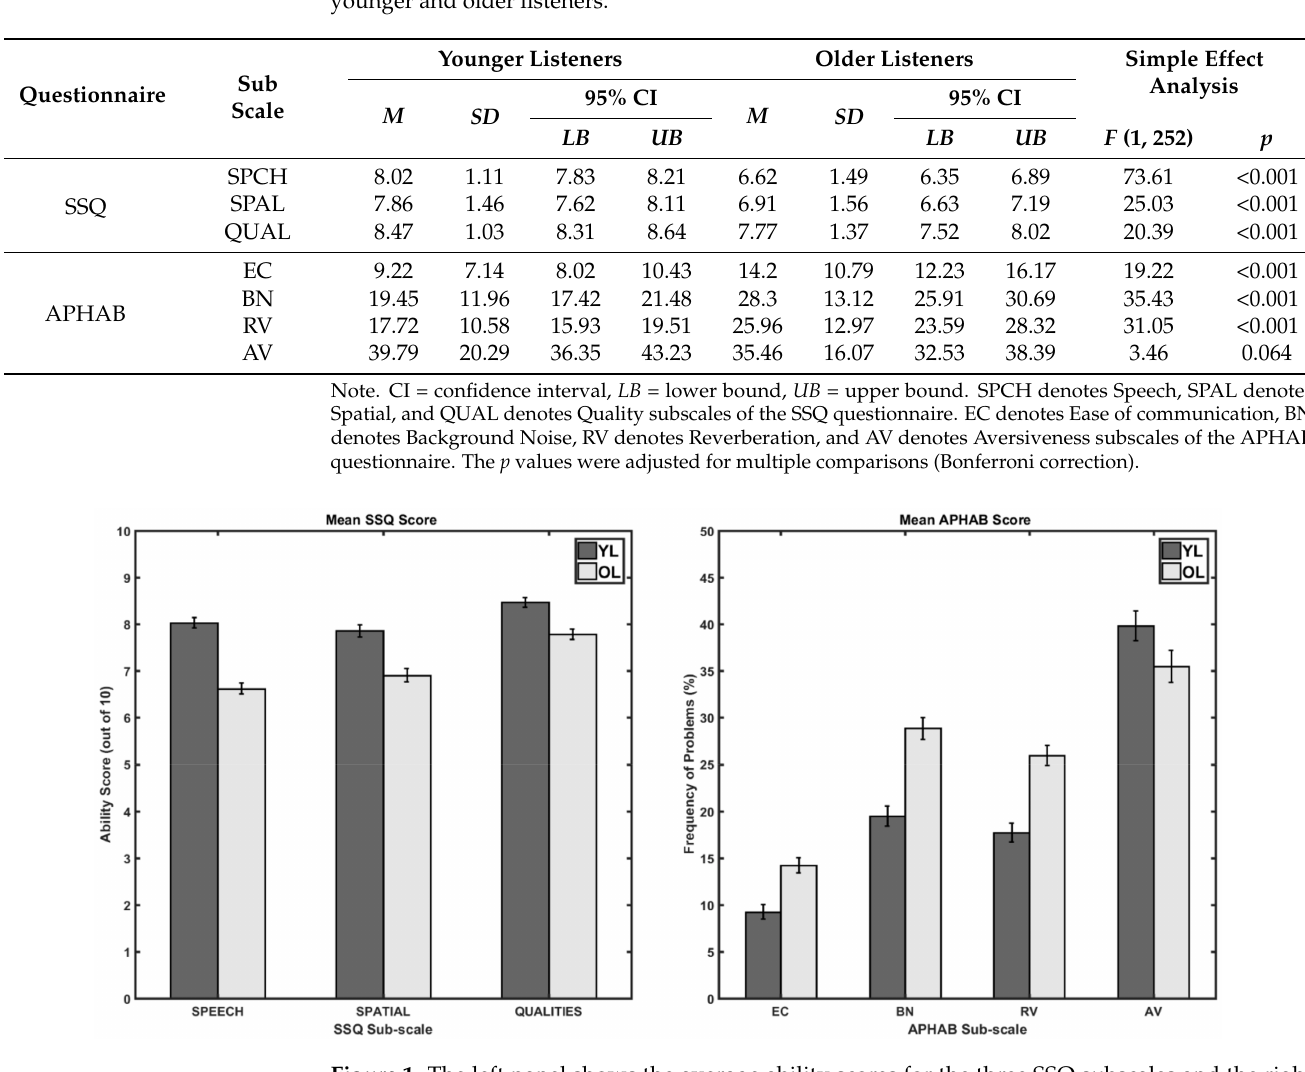
Figure 1. The left panel shows the average ability scores for the three SSQ subscales and the right panel shows the average percentage of problems encountered for the four APHAB subscales (EC: Ease of Communication; BN: Background Noise; RV: Reverberation; AV: Aversiveness) for the younger (darker bars) and older (lighter bars) listeners. The error bars indicate ± 1 SEM. Note that more hearing difficulties are indicated by smaller and taller bars in the right and left panels,